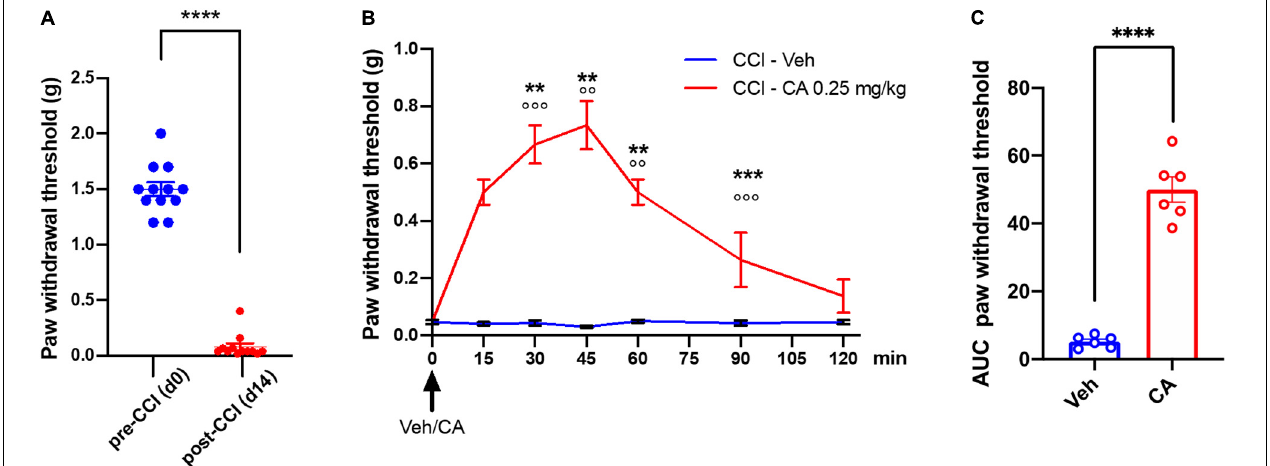
FIGURE 3 | Single injection of cinnabarinic acid showed analgesic effect in WT CCI mice. (A) Paw withdrawal thresholds in CCI mice recorded before (day 0) and after (day 14) CCI surgery. Data are expressed as the means ± SEMs [paired t -student test, **** p < 0.0001 vs. pre-CCI (d0), n = 12]. (B) Time-course of paw withdrawal threshold (g) measurements before and after single injection of vehicle or CA (0. 25 mg/Kg) in CCI mice, recorded for 120 min at 15 min intervals. Data are expressed as the means ± SEMs [two-way ANOVA for repeated measures with Tukey’s or Sidak post-hoc test for differences within and between group of animals, ** p < 0.01, *** p < 0.001 and **** p < 0.0001 vs. pre-drug (time 0), ◦◦ p < 0.01 and ◦◦◦ p < 0.001 vs. vehicle, n = 6]. (C) The area under curve (AUC) analysis (normalized to -1 d values) of paw withdrawal threshold differences in between vehicle and CA-injected CCI mice. Data are expressed as the means ± SEMs (unpaired t -student test, **** p < 0.0001 vs. CCI-Veh, n =